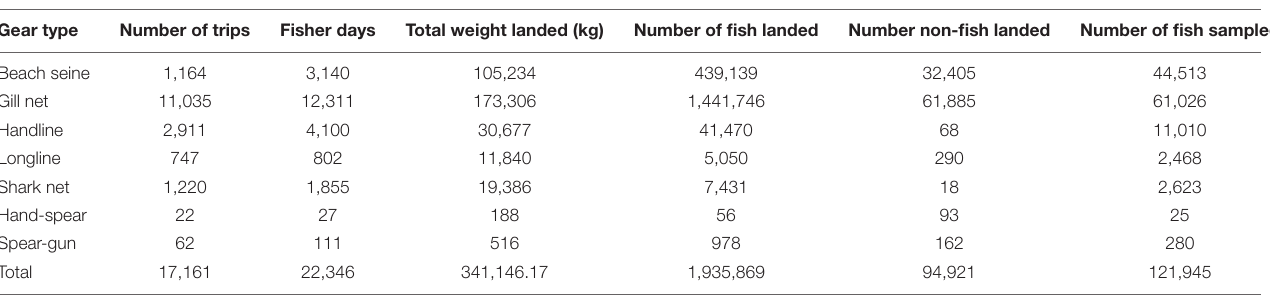
TABLE 1 | Summary information for each gear type surveyed during the